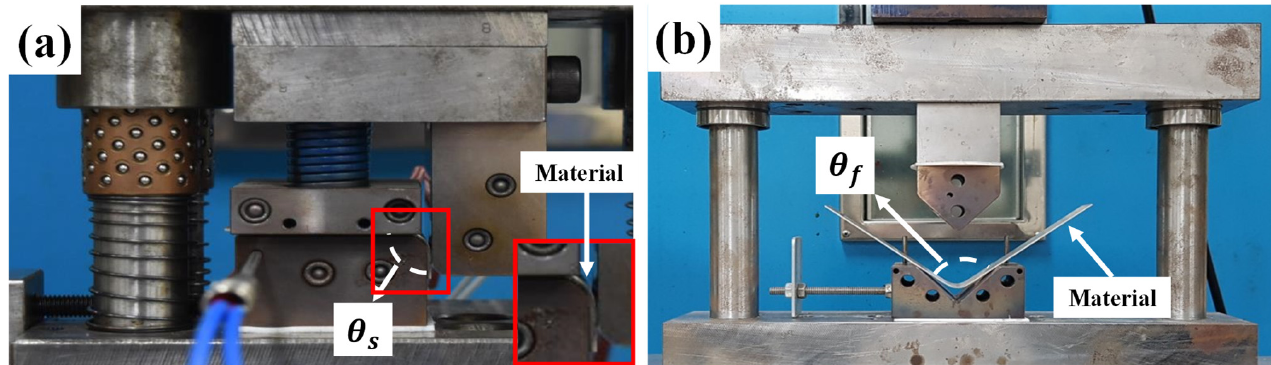
Figure 4. The die set of ( a ) L-bending and ( b ) V-bending